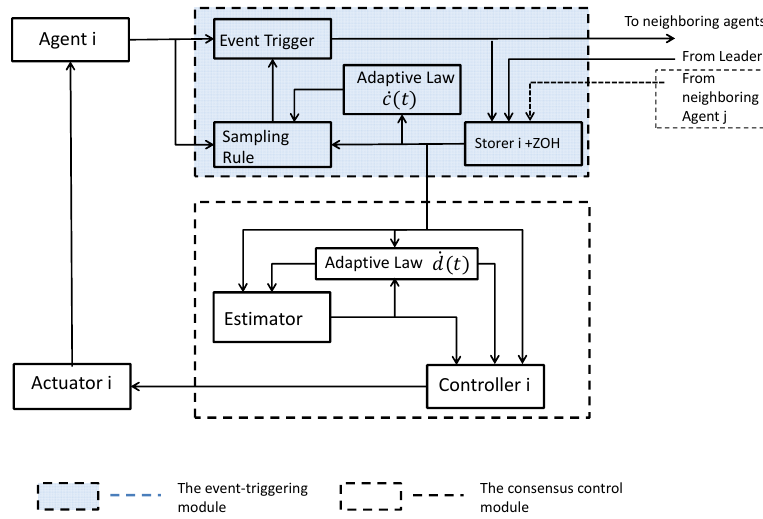
Figure 1. A fully distributed event-triggered transmission strategy for agent- i